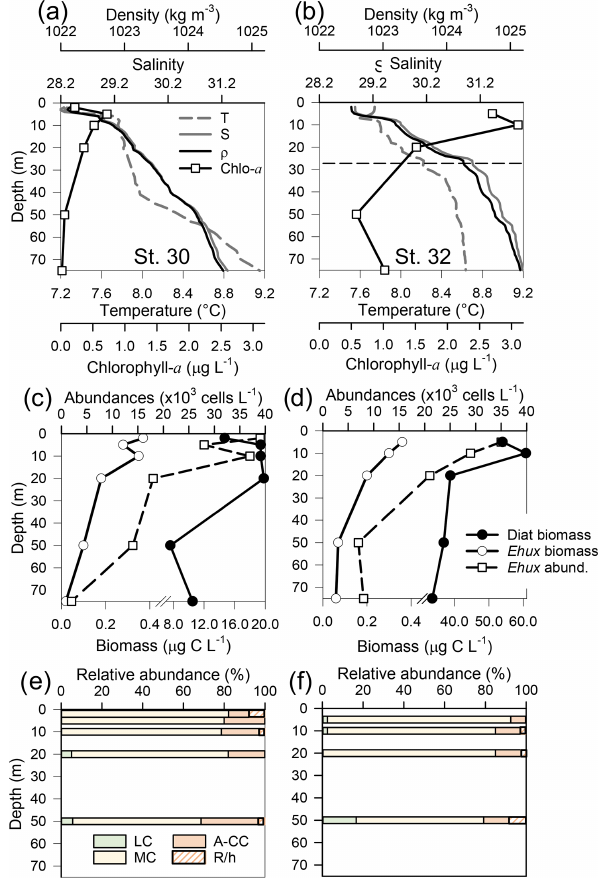
Figure 6. Physical, chemical, and biological vertical profiles recorded in the Archipelago Madre de Dios during early aus- tral spring 2017. Temperature, salinity, density, and total chloro- phyll a (a–b) , abundance of E. huxleyi and total carbon biomass of E. huxleyi ( Ehux ) and diatoms (Diat; c–d ), and relative abundances of four E. huxleyi morphotypes (e–f) in the W-AMD (St. 30 left) and the E-AMD (St. 32 right). Dotted line in (b) indicates depth of 1% PAR penetration (St. 30 was conducted at night). Morphotype abbreviations as in Fig. 3. See Fig. S9 for additional